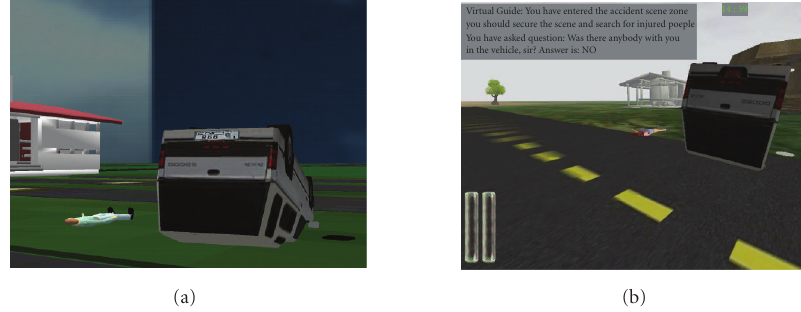
Figure 4: (a) Smart terrain running on bespoke engine, (b) the same G-factor running on Torque [24].